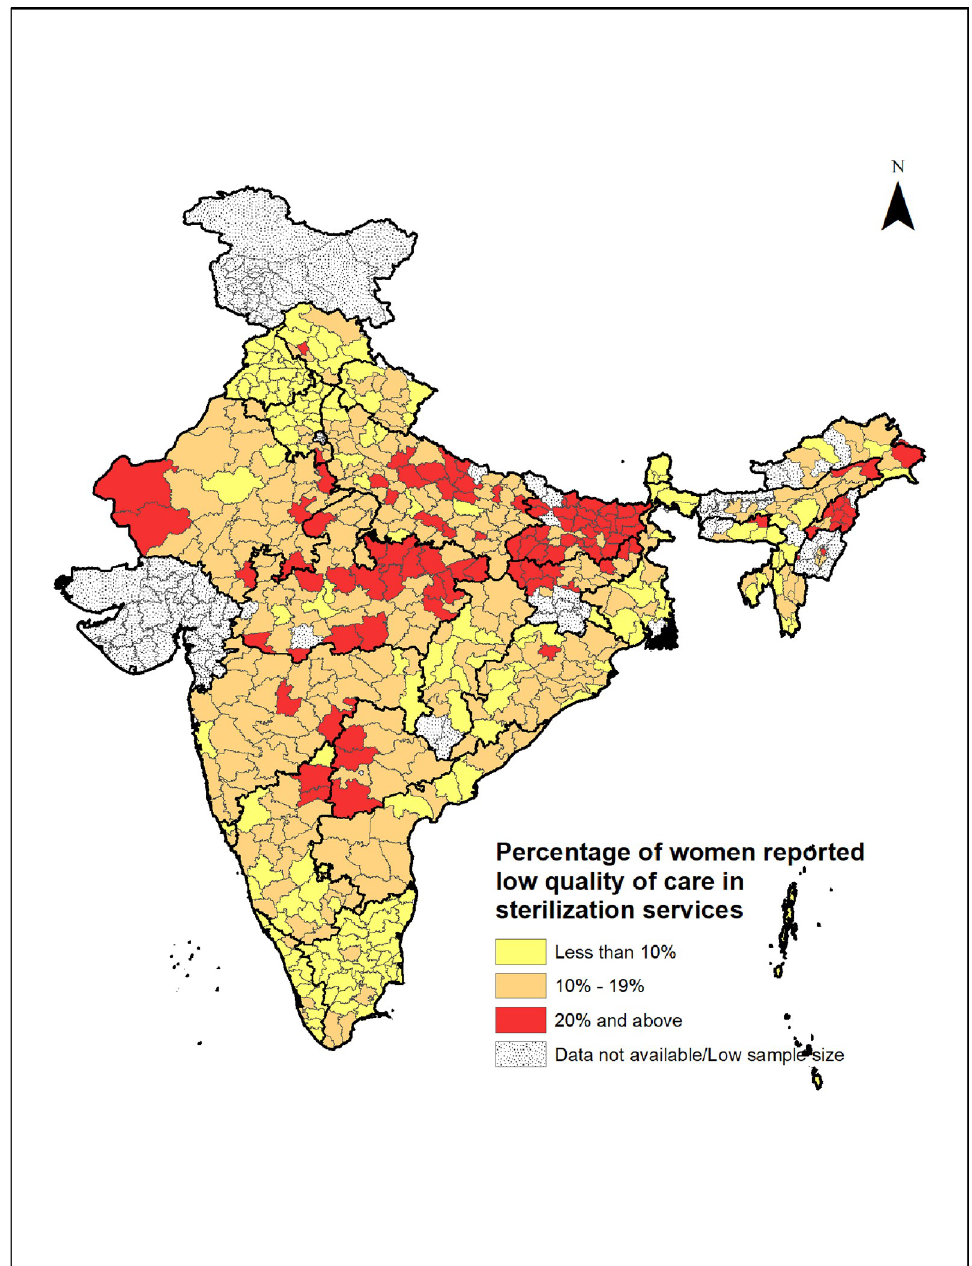
Fig 2. Distribution of Indian districts by the percentage of clients reported ‘low’ quality of care score for sterilization service, NFHS 2015–16.